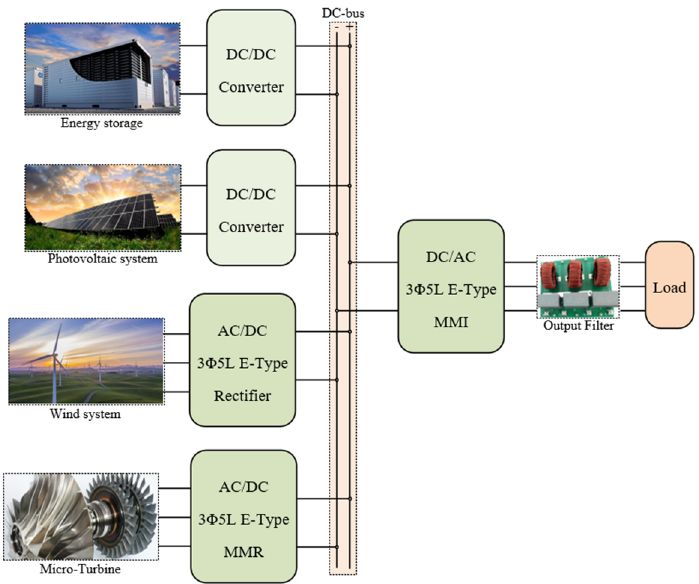
Figure 1 . Structure of stand-alone microgrid with the integrated renewable energy source. Figure 1. Structure of stand-alone microgrid with the integrated renewable energy